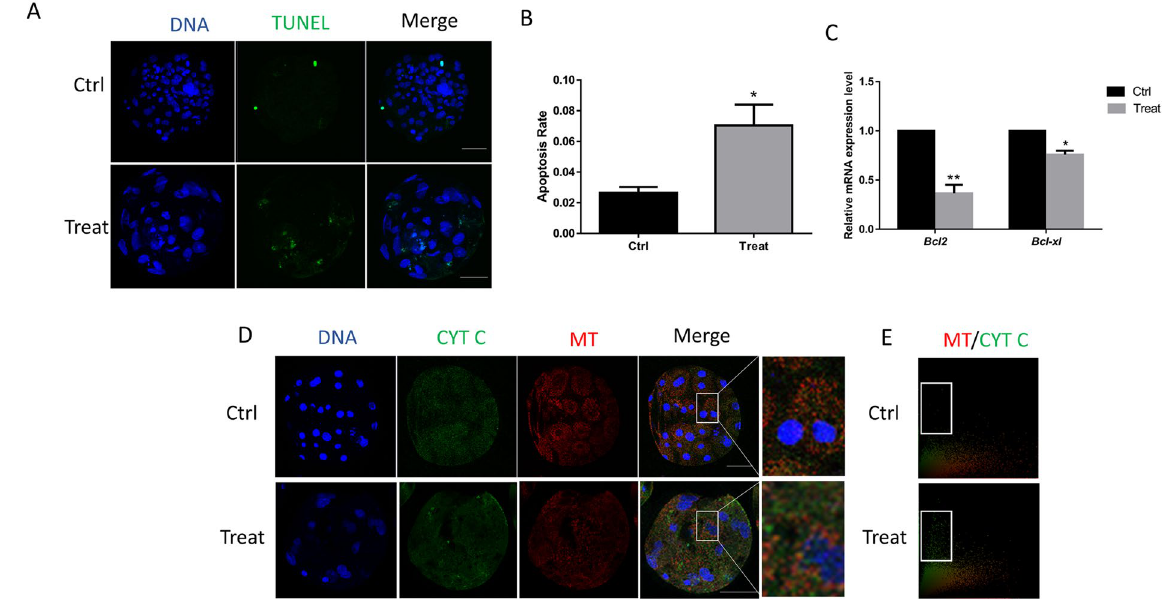
Figure 3. Effect of BPA exposure on apoptosis. ( A ) TUNEL-positive cells were detected in the presence or absence of BPA. ( B ) The rate of TUNEL-positive and total cells are shown. ( C ) Relative mRNA expression level of Bcl2 and Bcl-xl in blastocysts with or without BPA exposure. ( D ) The localization of cytochrome c and mitochondria was detected using immunostaining. ( E ) The localization of cytochrome c and mitochondria in the whole blastocyst. * P < 0.05. Ctrl, control; Treat, treatment. Scale bar: 50 μ m. MT: mitochondria; CYT C: cytochrome c.